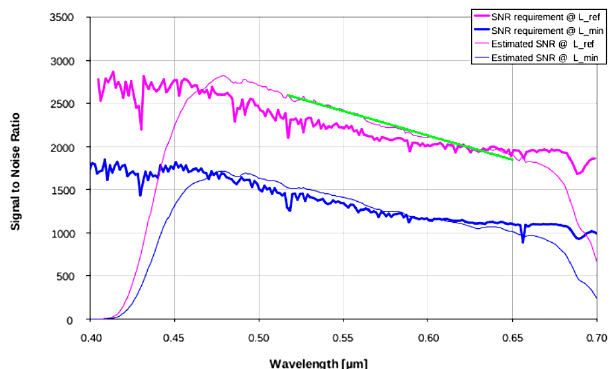
Figure 1. Calibration curves representing the variation of the SNR with respect to the wavelength for the MAGEAQ VIS instrument. The pink lines indicate the SNR for the typical radiance case (L_ref) and the blue lines indicate the SNR for the minimal radiance case (L_min). The thick lines show the SNR requirement and the thin lines show the SNR estimated for the instrument. The thin pink curve is fitted by a linear line (green line) to derive the instrument noise